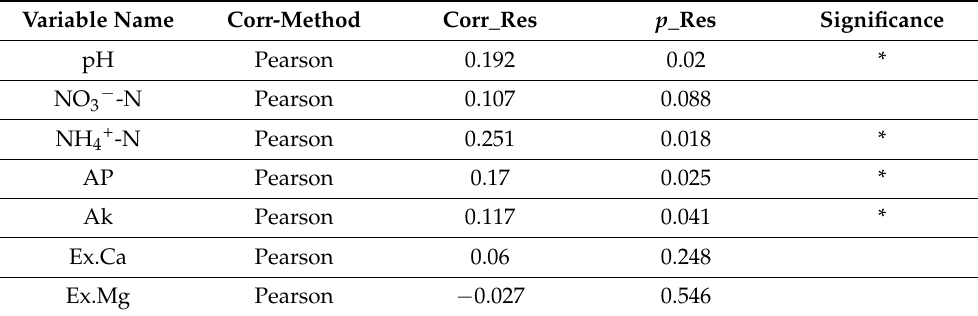
Table 3. Pearson correlation between the Bray–Curtis dissimilarity score and soil characteristics using the Mantel test.